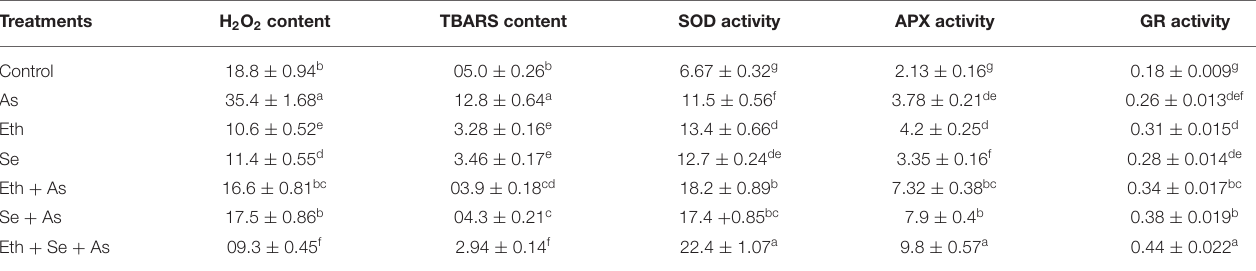
TABLE 1 | The H 2 O 2 content (nmol g − 1 FW), TBARS content (nmol g − 1 FW), SOD activity (U mg − 1 protein min − 1 ), APX activity (U mg − 1 protein min − 1 ), and GR activity (U mg − 1 protein min − 1 ) of mustard plant ( B. juncea L.) grown with 200 µ l L − 1 Eth and/or 2mg Se kg − 1 soil in the presence or absence of 24mg As kg − 1 soil at 30 DAS.